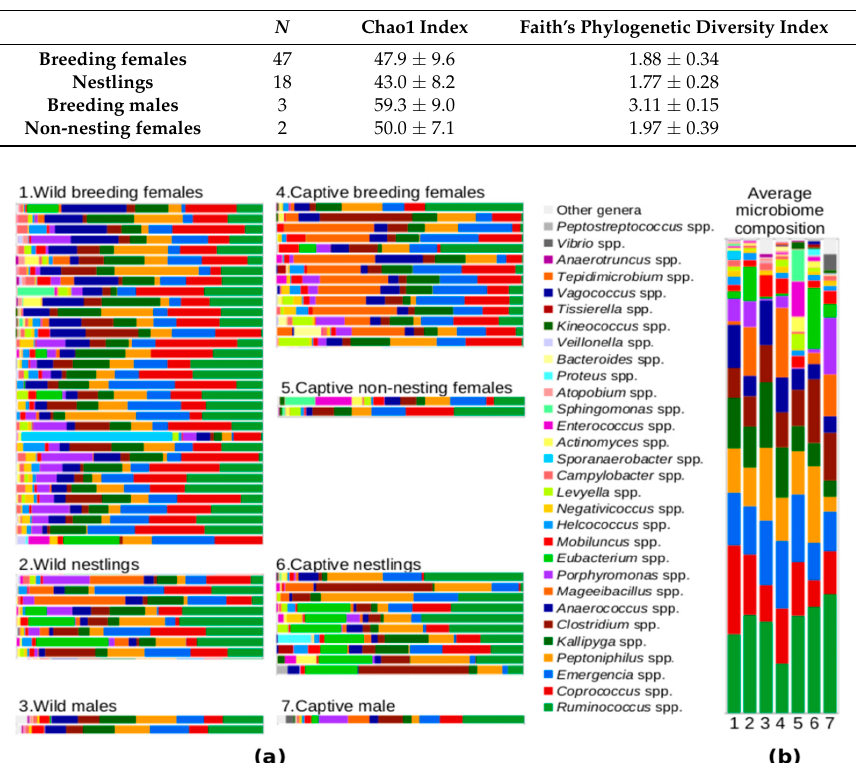
Figure 1. Relative abundance of genera in the hoopoe uropygial microbiota during the breeding season. Samples are organized in groups according to living conditions and sex and breeding phase. Both individual samples ( a ) and average composition for each group ( b ) are shown .